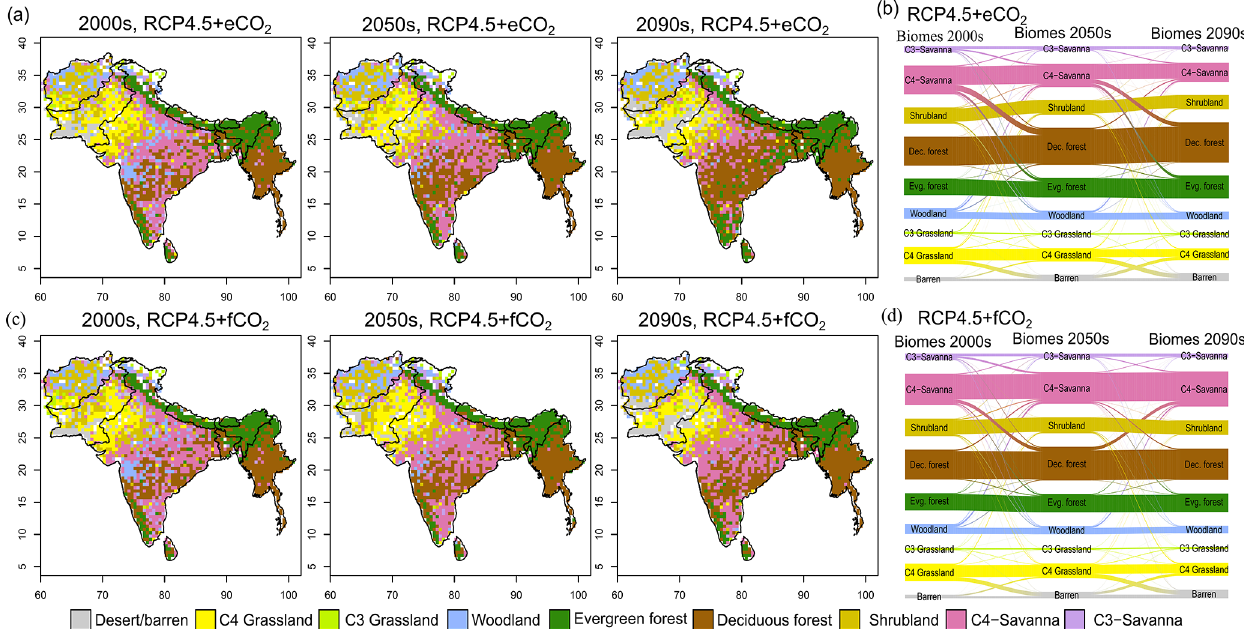
Figure 3. Simulated biome distribution for the 2000s, 2050s and 2090s under (a) RCP4.5 + e CO 2 and (c) RCP4.5 + f CO 2 . The Sankey diagrams show the fractional cover of biomes and transitions between biomes from the 2000s to the 2050s and the 2050s to the 2090s under (b) RCP4.5 + e CO 2 and (d) RCP4.5 + f CO 2 . See Fig. S6 for the simulated biome distribution under